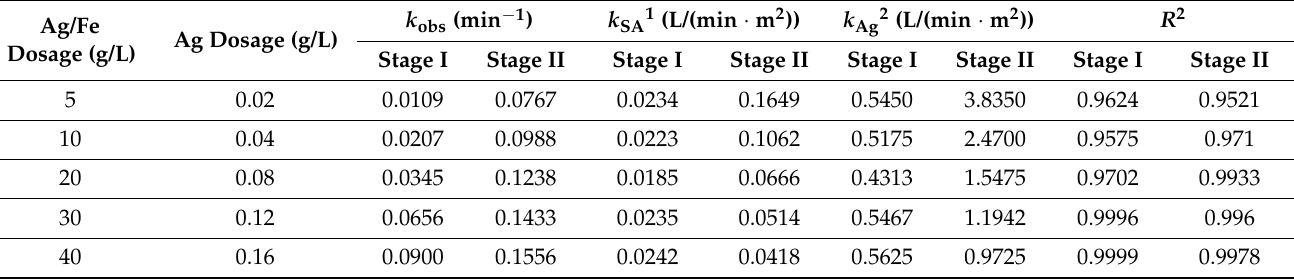
Table 4. Normalized rate constant for CCl 4 degradation by bimetallic Ag/Fe at different dosages.